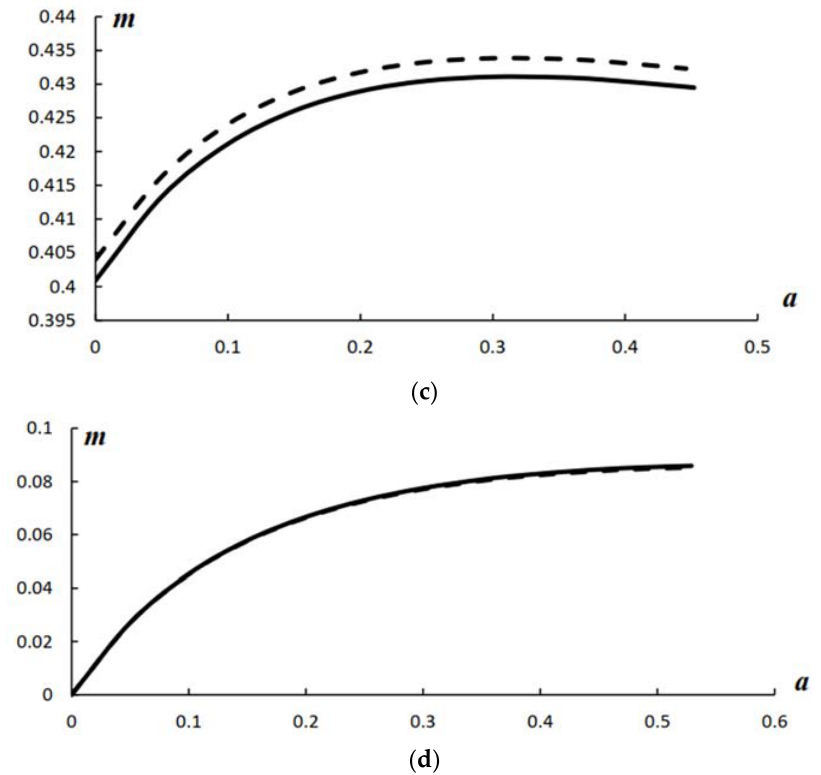
Figure 7. Effect of the design objectives in Table 1 on the dependence of the dimensionless bending moment on a . The solid curves correspond to Design ( a ) and the broken curves to Design ( b ). The